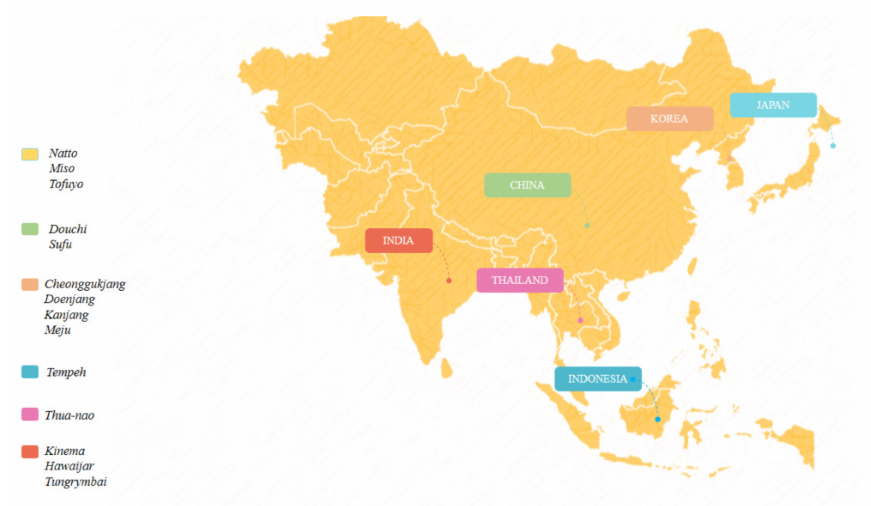
Figure 3. Products fermented soy in Asian